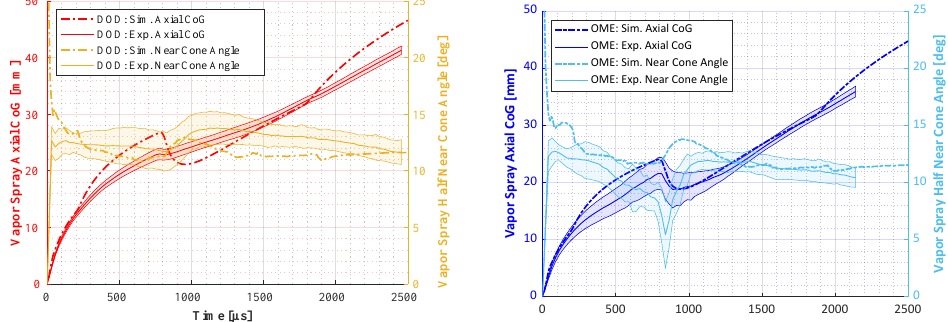
Figure 10. Conti3L ( AiM ): Multi-injection vapor spray dispersion (half near cone spreading angle and axial center of gravity): ( left ) Dodecane. ( right )